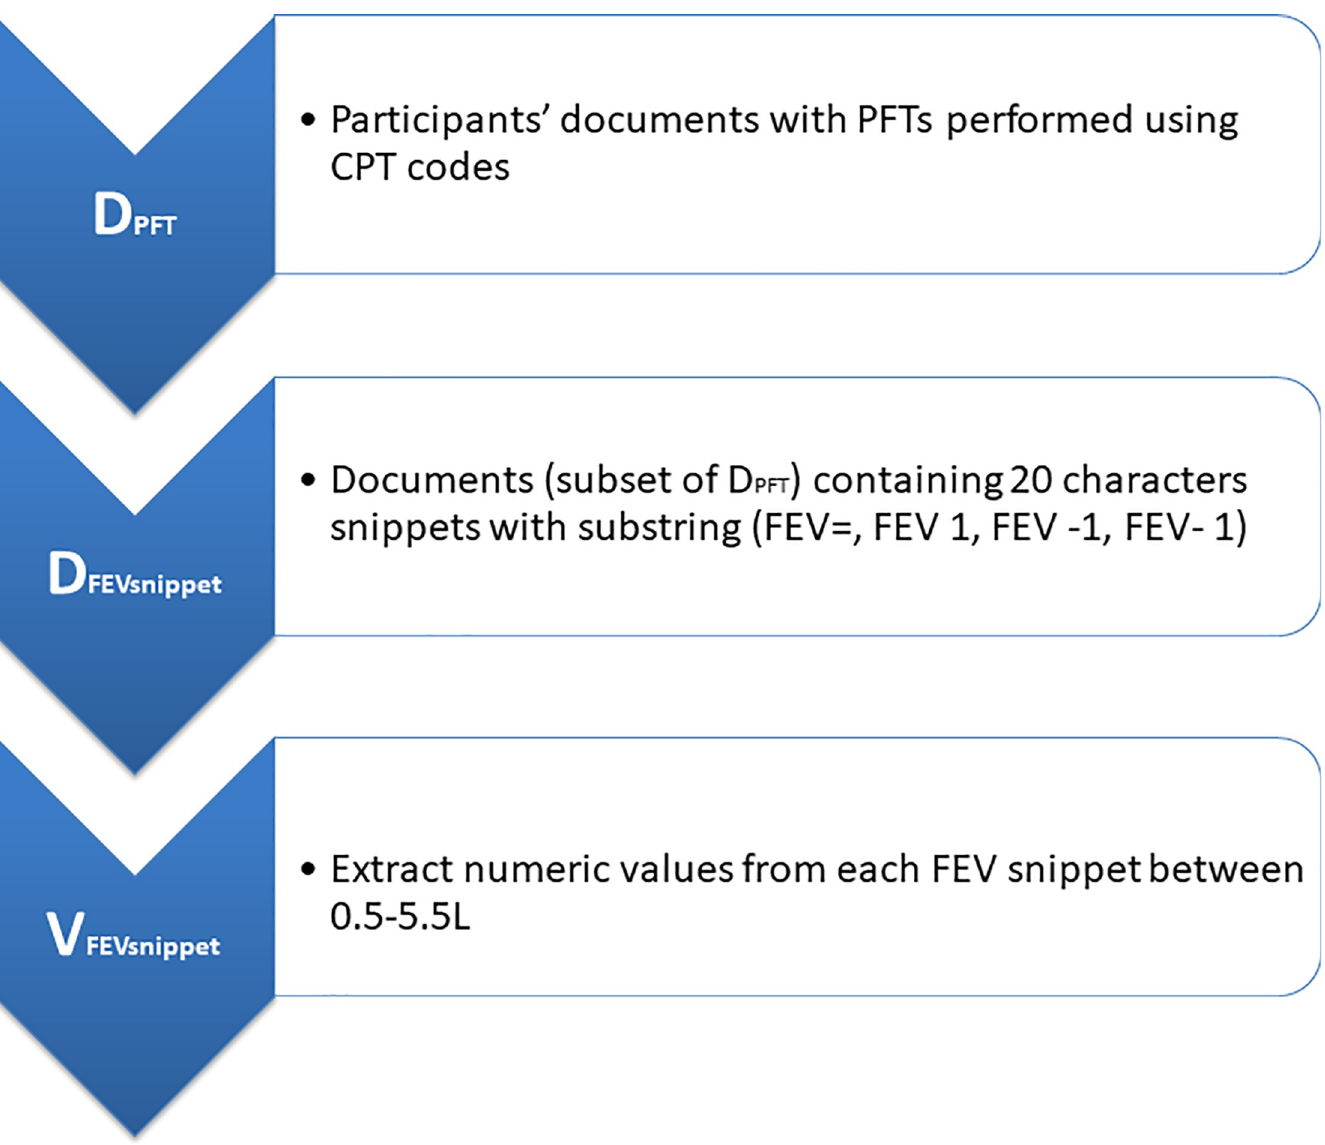
Fig 1. Algorithm implemented using SQL with fulltext search feature. Algorithm supported by MS SQLServer 2014.